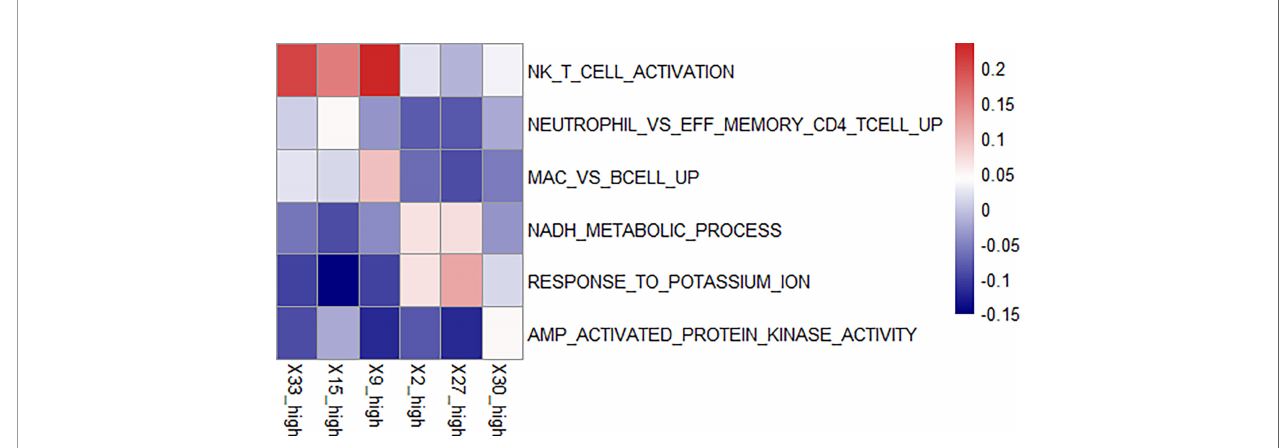
FIGURE 5 | Enriched pathways in each feature. We found enriched pathways in the high expression group of each feature. Features 33, 15, and 9 all had lymphocyte- enriched pathways, but the types of lymphocyte were different, which may explain the lymphocyte in fi ltration group was divided into three features. Because of the enrichment of immune cells, immunosuppressive therapy has a good effect on the group with high expression of these three features. The biological phenotype of feature 2 was associated with the morphology of blood vessels, and the enrichment of NADH biochemical metabolic pathways was seen in the group with high expression. Feature 27 was associated with loose connective tissue, and its high expression group was enriched for the pathway of potassium ion overexpression. Feature 30 was enriched for kinase-related pathways in the high expression group. The presence of these three features has a suppressive effect on immunosuppressive